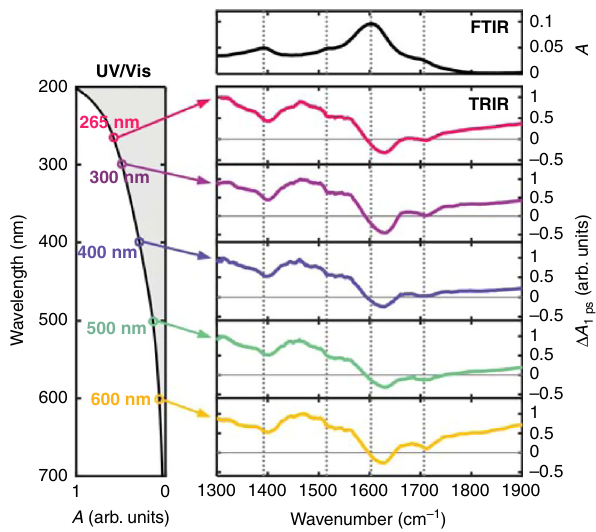
Fig. 4 Ultrafast vibrational fi ngerprinting of DOPA melanin. Time- resolved vibrational spectra (TRIR) are shown at 1 ps after photoexcitation at the wavelengths indicated on the left. Spectra are normalized for clarity. Vertical dotted lines indicate ground state vibrational peak positions. The electronic (UV-vis) and vibrational (FTIR) absorption spectra of DOPA melanin are shown on the left and top, respectively, with axes that are linear in absorbance.